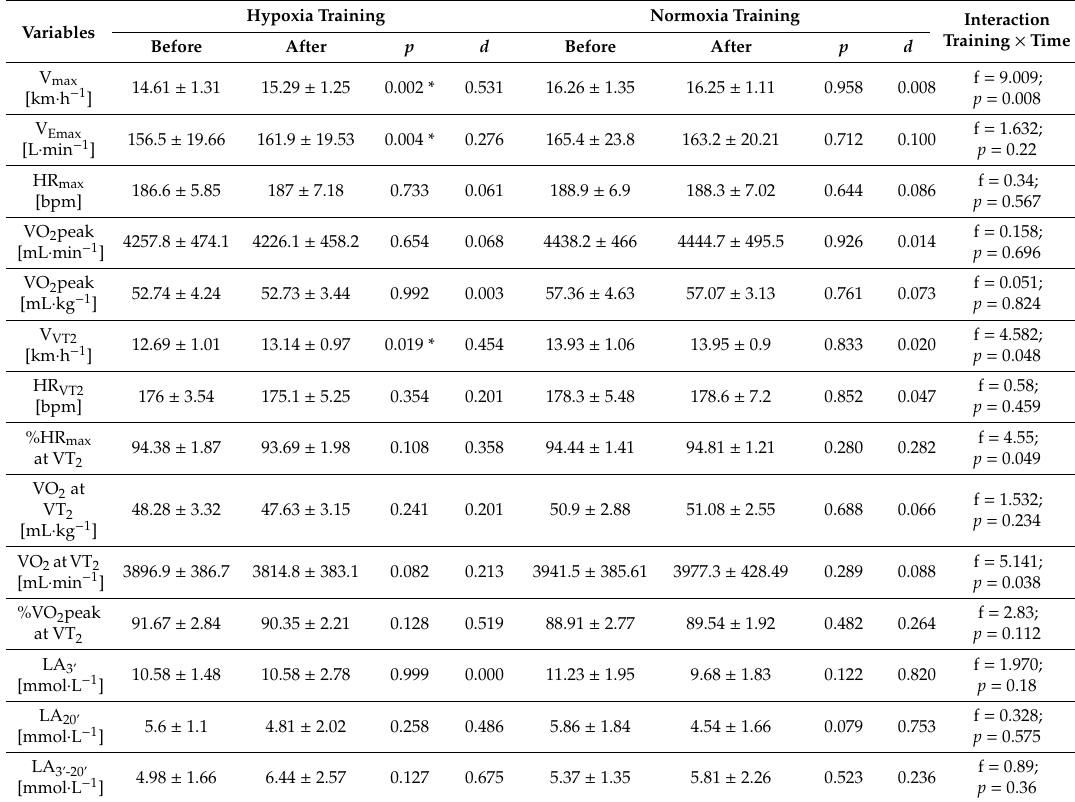
Table 5. Changes in indices of aerobic capacity under the influence of training in conditions of hypoxia and